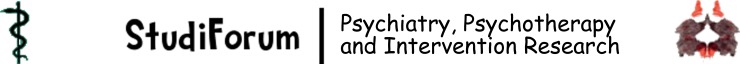
Translated version of the banner for the low source credibility group.